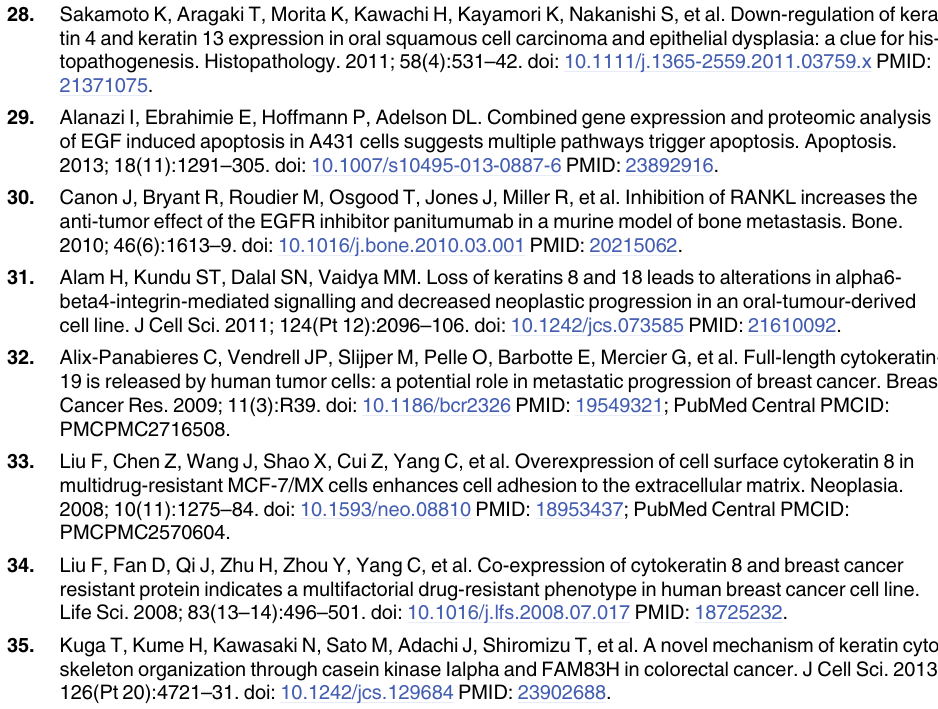
PLOS ONE | DOI:10.1371/journal.pone.0163232 October 6,